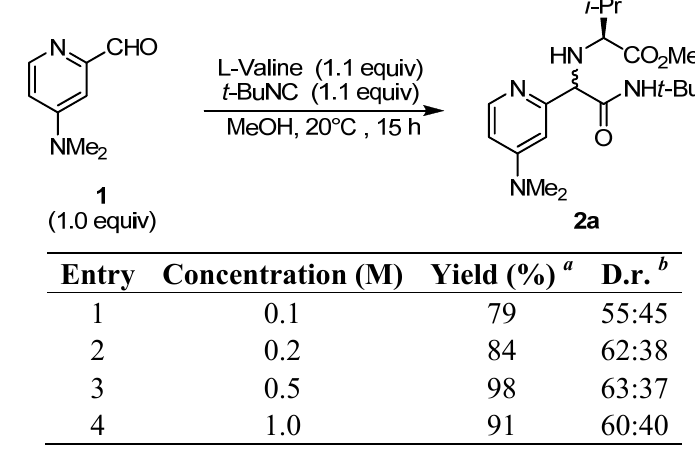
Table 1. Ugi reaction of 1 using various substrate concentrations.